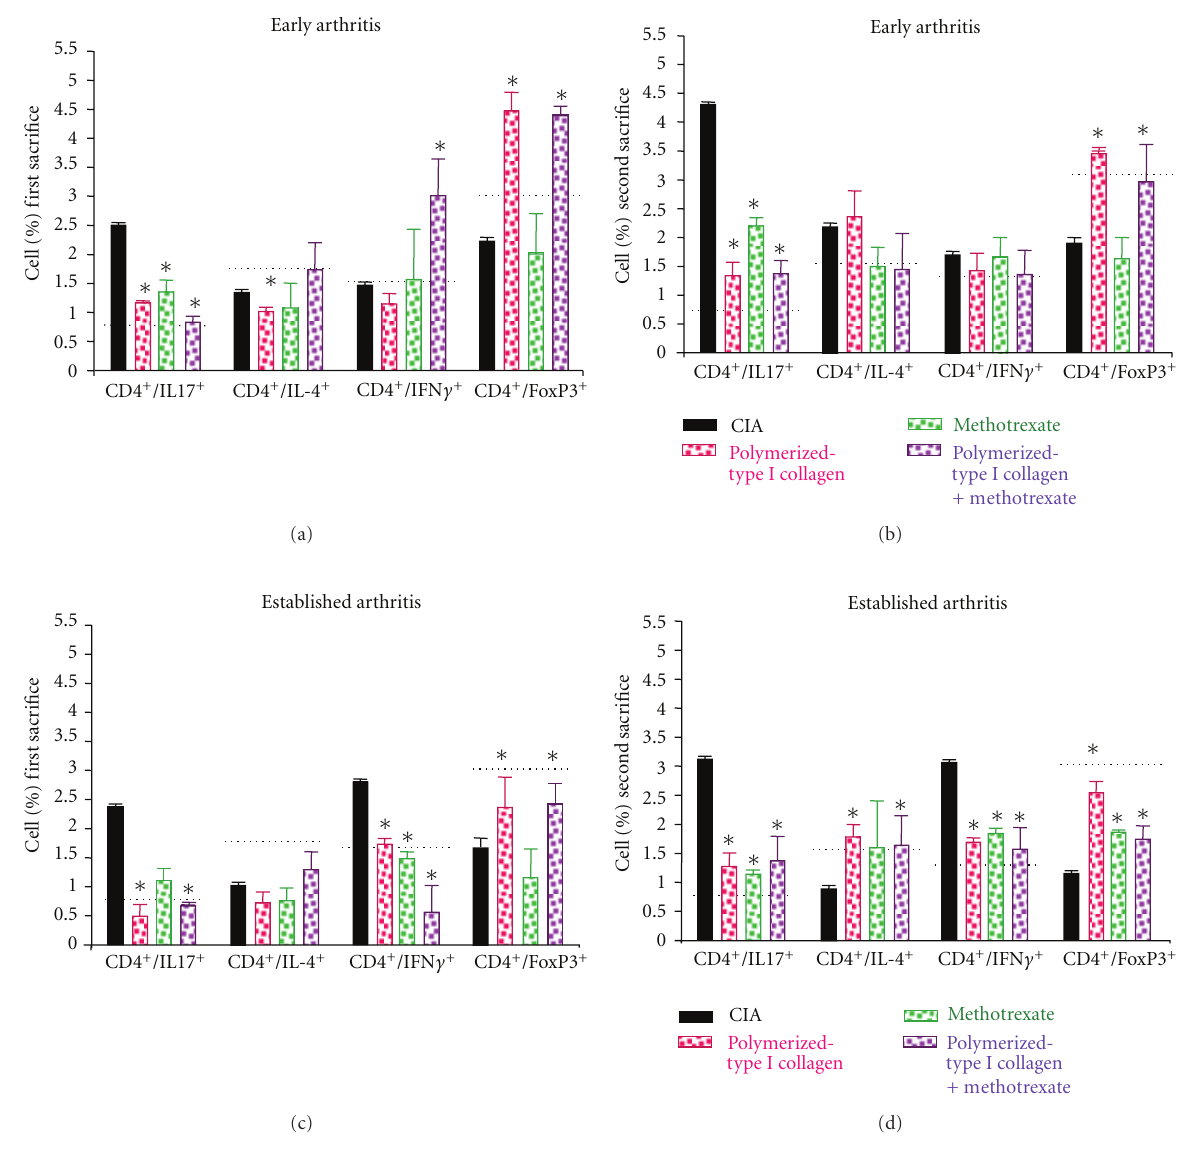
Figure 4: E ff ect of polymerized-type I collagen on the ex vivo intracellular cytokine production and on CD4 + T cell subsets regulation in splenocytes. (a) Spleen cells obtained immediately ex vivo in early arthritis model on day 35 after booster immunization. (b) Splenocytes obtained immediately ex vivo in early arthritis model on day 98 after booster immunization. (c) Spleen cells obtained immediately ex vivo in established arthritis model during first sacrifice. (d) Splenocytes obtained from established arthritis model during second sacrifice. Intracellular production of IL-17A, IL-4, IFN- γ , and Foxp3 by CD4 + T cells was detected by flow cytometry. Results are representative of 6 mice analyzed in each group. Horizontal dotted line represents mean normal values, obtained from mice ( n = 3) without CIA. Data represent mean ± SEM. ∗ P < 0 .